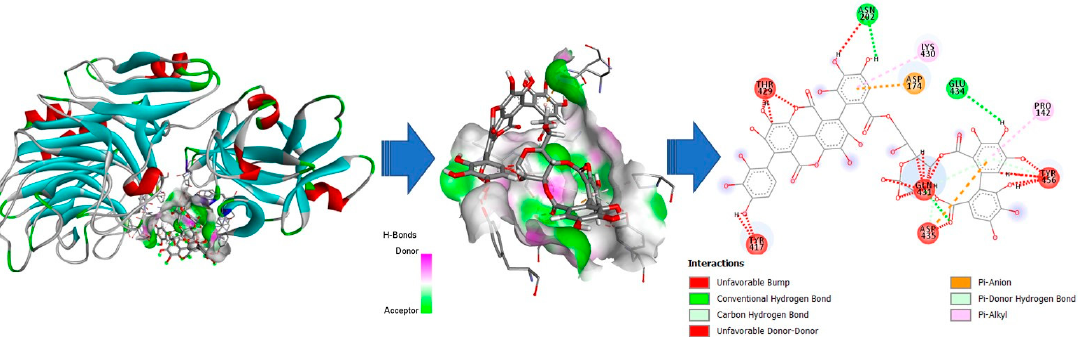
Figure 6. Docking analysis for the interaction between EAH 1 and punicalagin. The ligand-binding site residues are: PRO142, ASP,174, ASN202, TYR417, THR429, LYS430, GLN431, GLU434, ASP435, and TYR456.